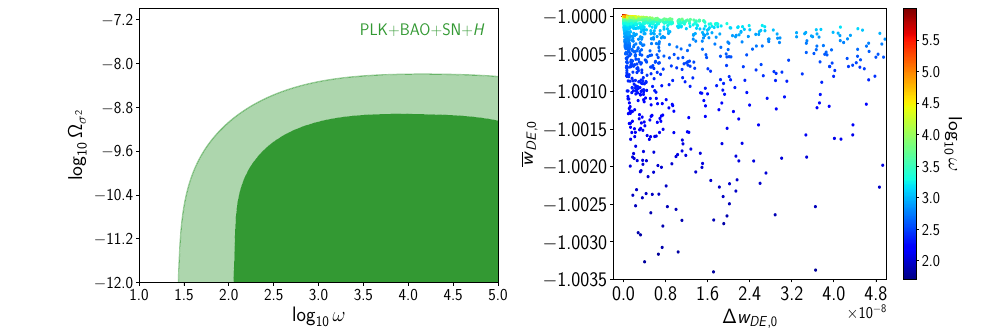
Fig. 2 (Left panel): 2D marginalized posterior distribution of the parameters log 10 (cid:4) σ 2 and log 10 ω that determine the extension from the standard (cid:2) CDM model. The 2D constraints are plotted with 1 σ Fig. 3 (Left panel) 2D marginalised posterior distribution of the parameters corresponding to the mass of the Jordan field M and the Brans–Dicke parameter log 10 ω . (Right panel) 1D constraints corresponding to the redshift of matter-radiation equality ( z eq